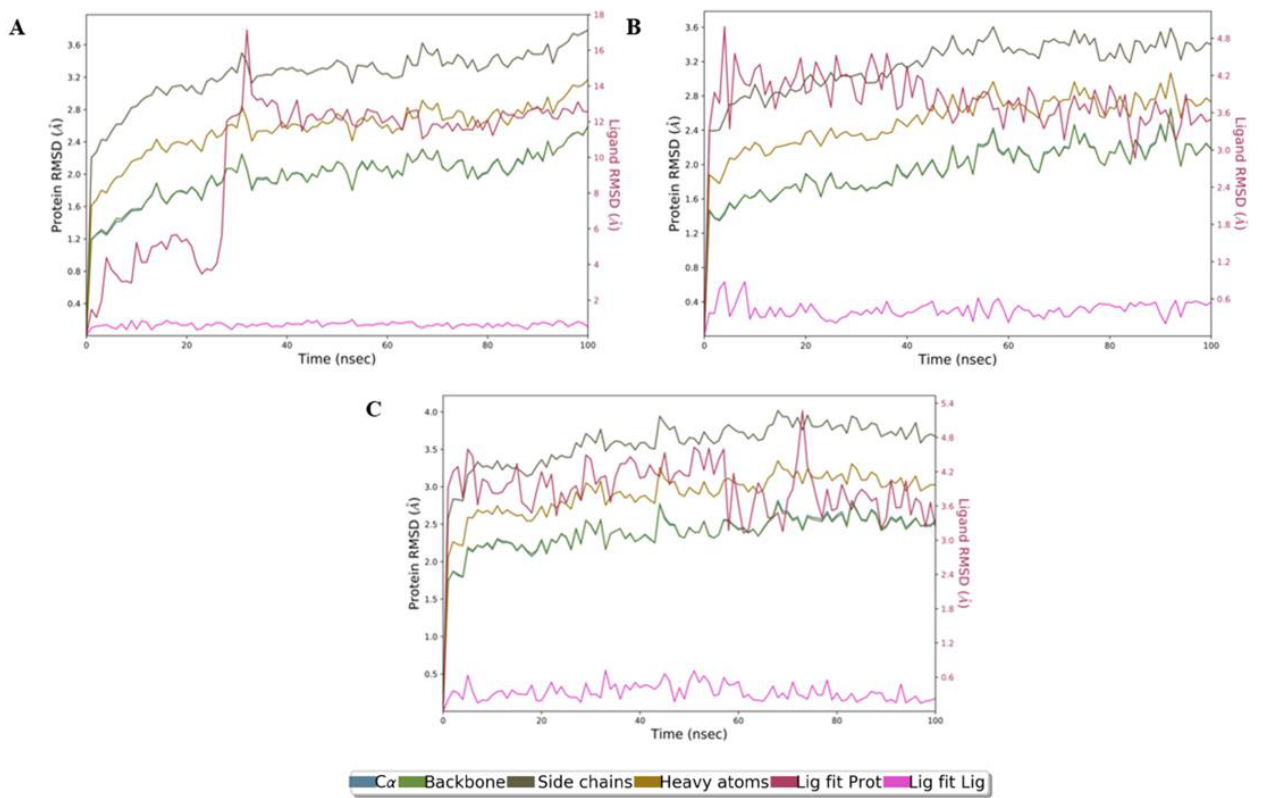
Figure 7. RMSD plot of human placental aromatase cytochrome P450 target and three compounds as a function of simulation time. ( A ) (50), ( B ) (52) and ( C ) (54). Color legends: Cα (blue color), side chains (green color), heavy atoms (yellow color), ligand with protein (dark pink color) and ligand with ligand (pink color).